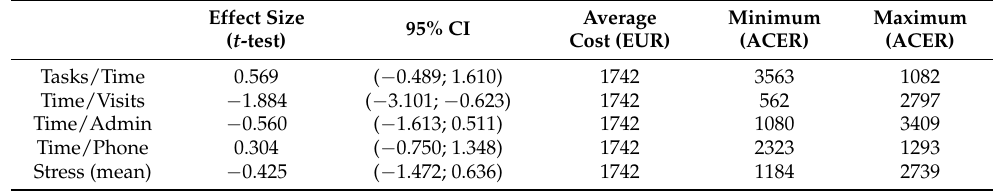
Table A1. Sensitivity analysis, minimum and maximum average cost-effectiveness ratios. Out- comes .